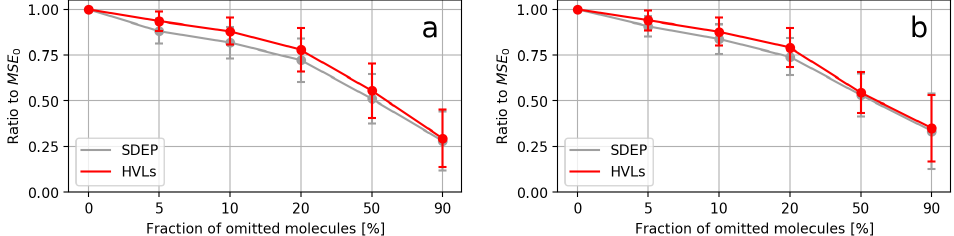
Figure 7. Average MSE s for each fraction across all datasets. The vertical bars at each point indicate standard deviations. For comparability, all MSE s were divided by the MSE 0 before averaging. ( a ) Plot for evaluations using RDKit descriptors. ( b ) Plot for evaluations using